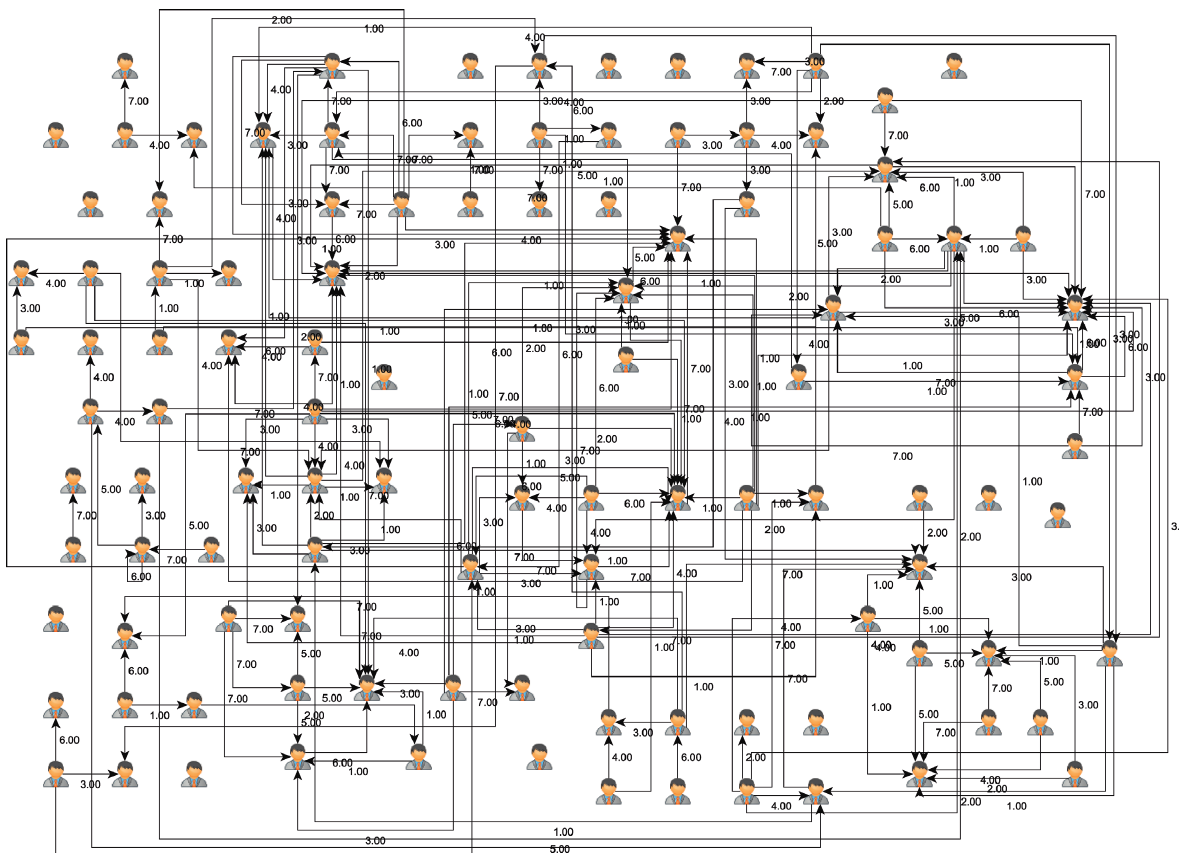
Figure 1: Network of employees at time t �